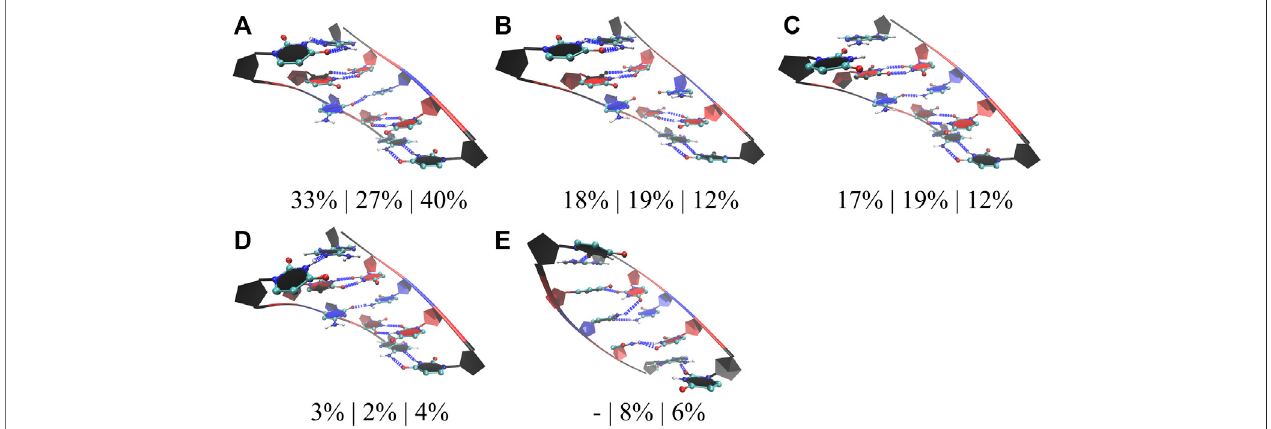
FIGURE 4 | Cluster analyses performed on three model RNA systems, 2×AUUCU, 4×AUUCU, and 10×AUUCU, mimicking AUUCU repeat expansions. Panels (A – E) display stable states observed in the MD trajectories such as states with one (A,C,D) , zero (B) , and two hydrogen bond states (E) observed in 1×1 CC non- canonical base pairs. Residues colored in red, and blue represent uridine and cytidine, respectively, while closing base pairs are displayed in black and in new ribbon forms. Dashed blue lines represent the hydrogen bonds observed in the structures. Three percentages displayed under each structure represent how often the conformations are observed in the MD trajectories of the three model systems in the same order described above. Note that in (C,D,E) , one or both of the closing AU base pairs are distorted.